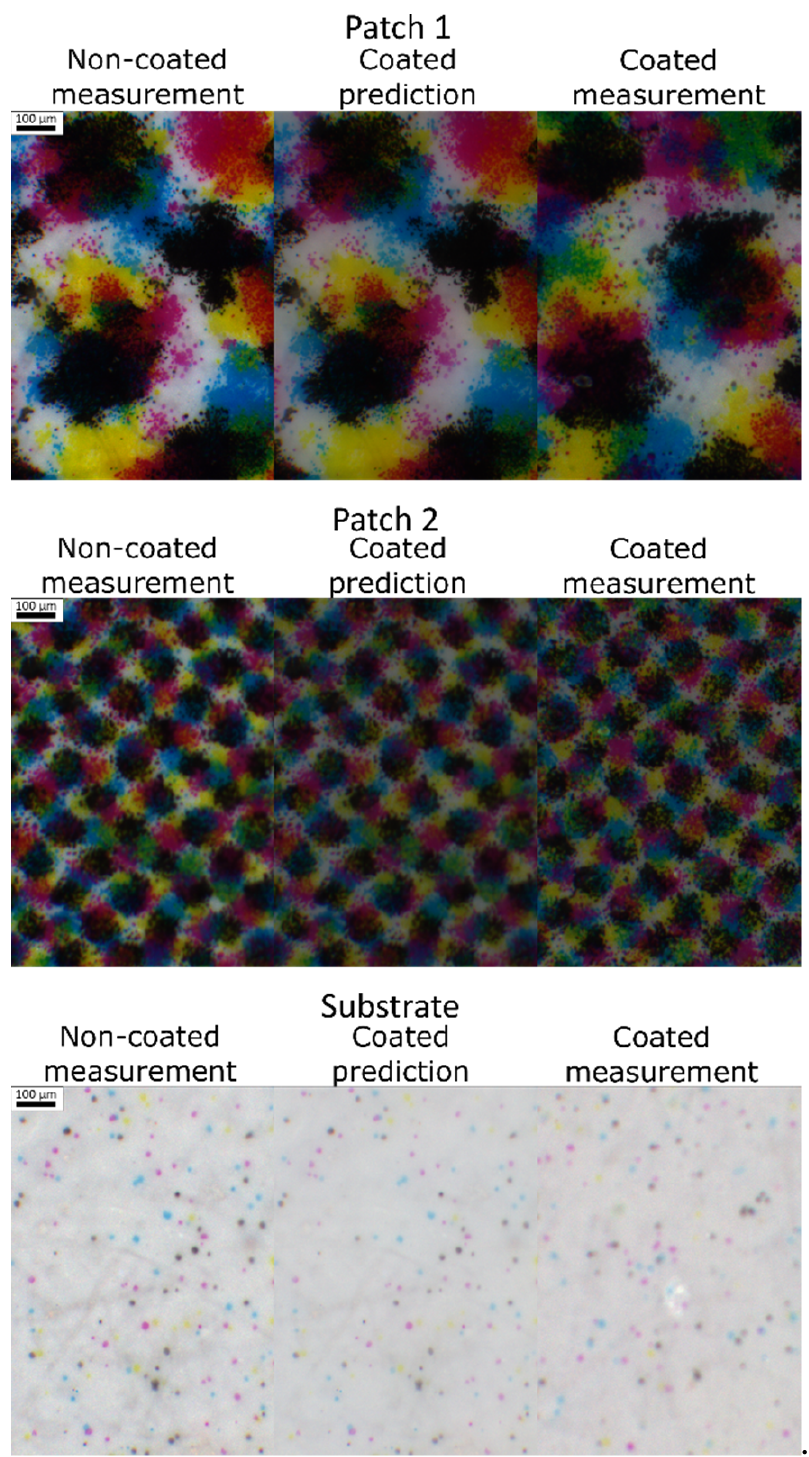
Figure 12. sRGB pictures of the multi-ink dot halftones: non coated on the left, predicted in the middle, and coated on the right.